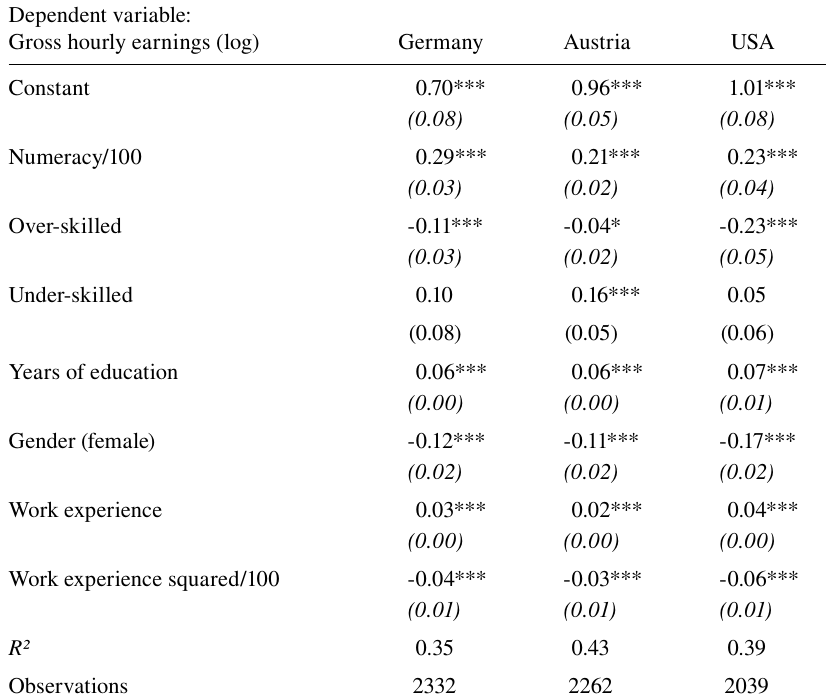
Table A.4 Mincer regressions with skill-mismatch according to the OECD